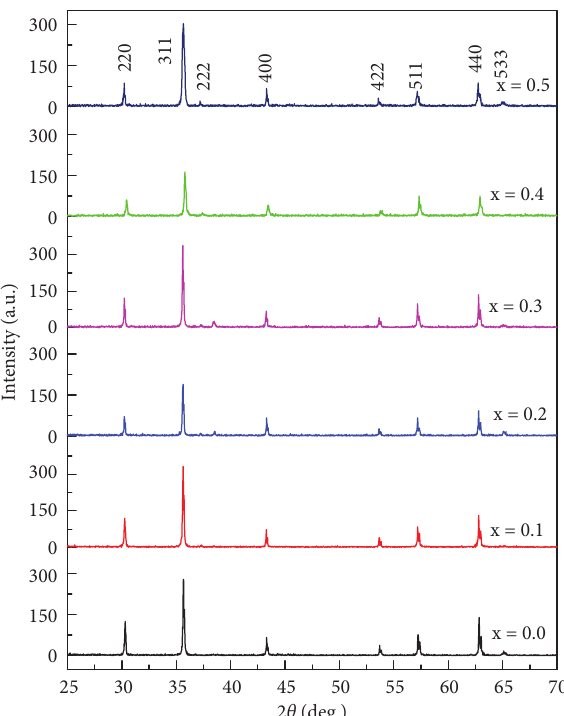
1-x Cu x Fe 2 O 4 sintered at